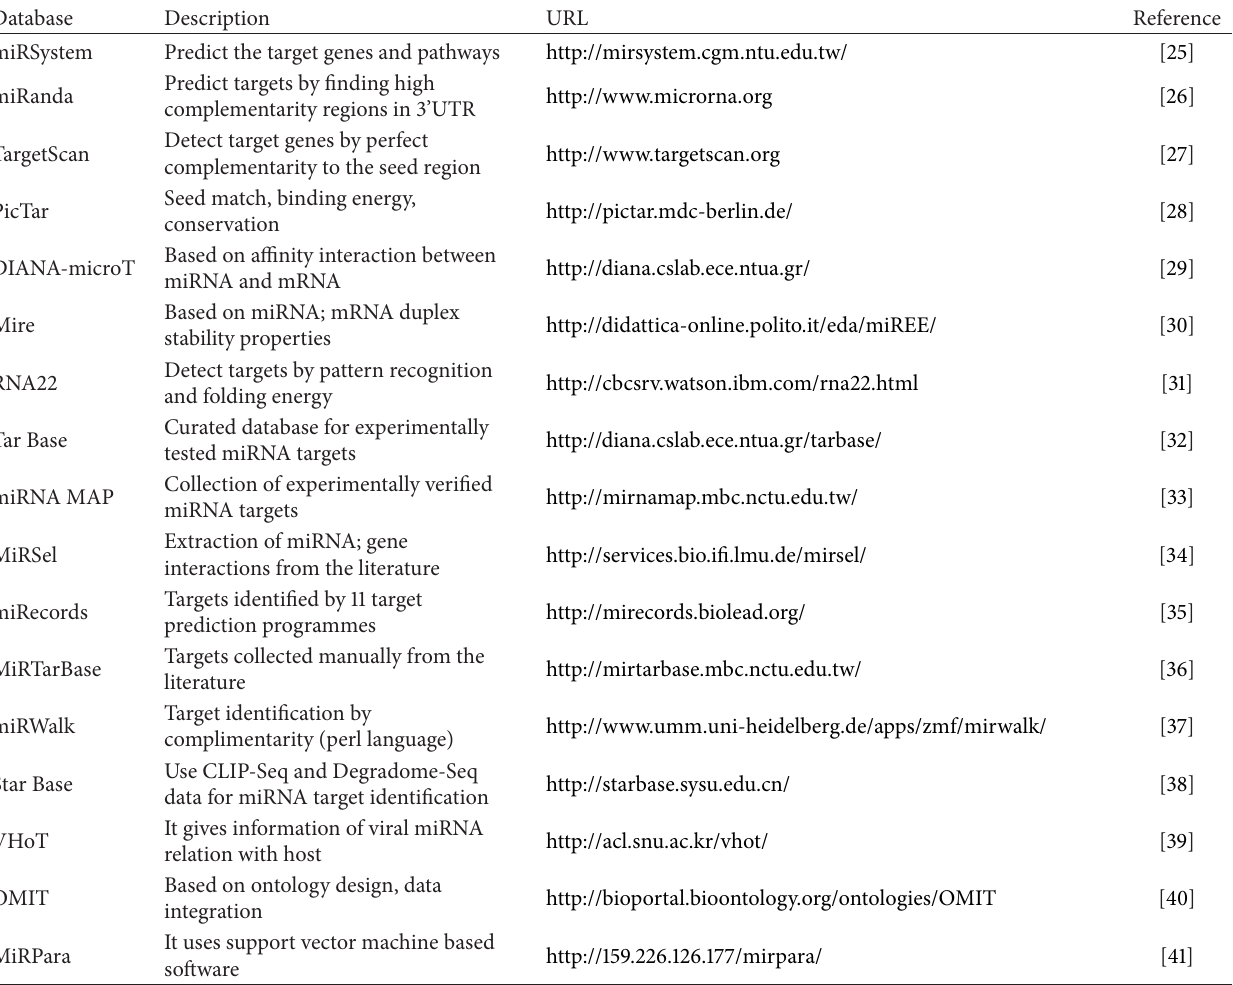
Table 3: miRNA target prediction